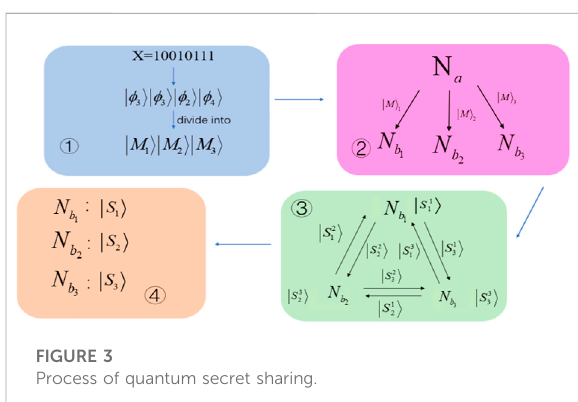
FIGURE 3 Process of quantum secret